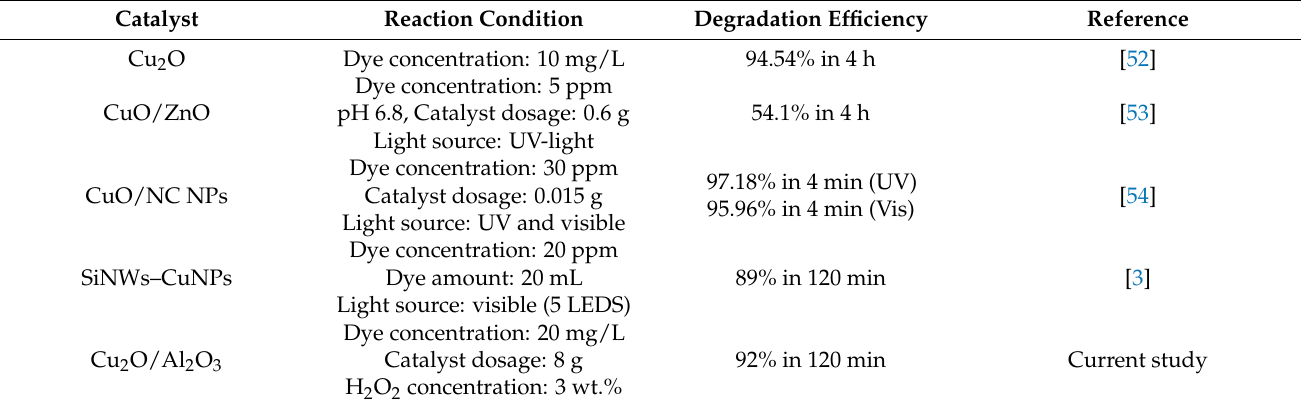
Table 3. Comparison of degradation efficiency of Cu 2 O/Al 2 O 3 coating with other catalysts reported in the